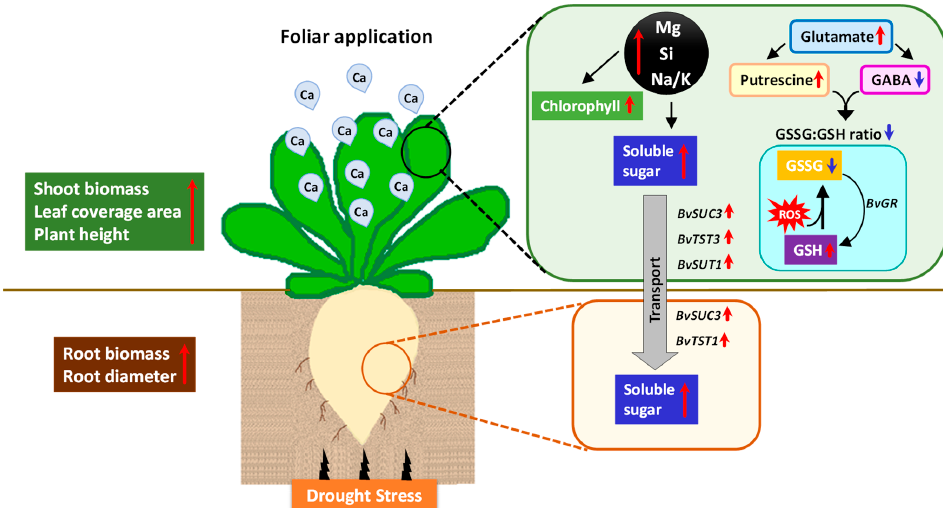
Figure 8. Schematic model representing the regulatory role of Ca 2+ on the response of sugar beet plants to drought stress. Ca 2+ treated sugar beet plants effectively tolerated drought stress by regulating the concentration of Mg and Si in the leaves which consequently enhanced sugar metabolism both at the metabolic and transcriptional level. Ca 2+ also increased the Na/K ratio in leaf displaying the possible role of Na in osmotic adjustment under drought stress. Shoots displayed increased leaf coverage area, higher biomass, and higher chlorophyll, along with increase in the beetroot diameter and beetroot biomass. Additionally, the lower GSSG/GSH ratio, higher putrescine levels, and reduced GABA level clearly showed that the Ca 2+ treated plants were able to efficiently tolerate drought-induced oxidative stress. (Red arrows = increase/upregulation, blue arrows = decrease/downregulation). Supplementary Materials: Supplementary materials can be found at www.mdpi.com/xxx/s1.